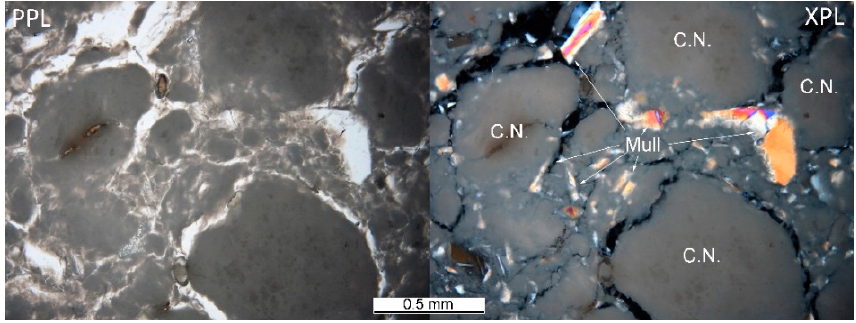
Figure 3. Sample K-T–fired clay nodules surrounded by mixture of fired clay and mullite; PPL = plane polarized light, XPL = crossed polarized light.